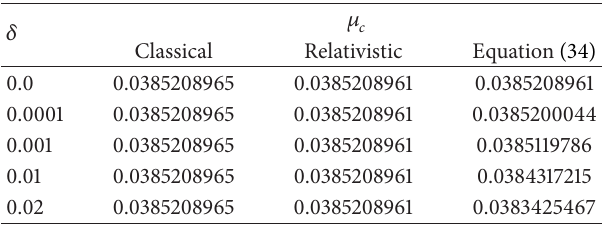
Table 6: Critical Mass. Sun-Saturn system: 𝑐 = 31050.90 , 𝜇 = = 0.0000018690 × 10 −8 0.00028572600 , and 𝐴 2